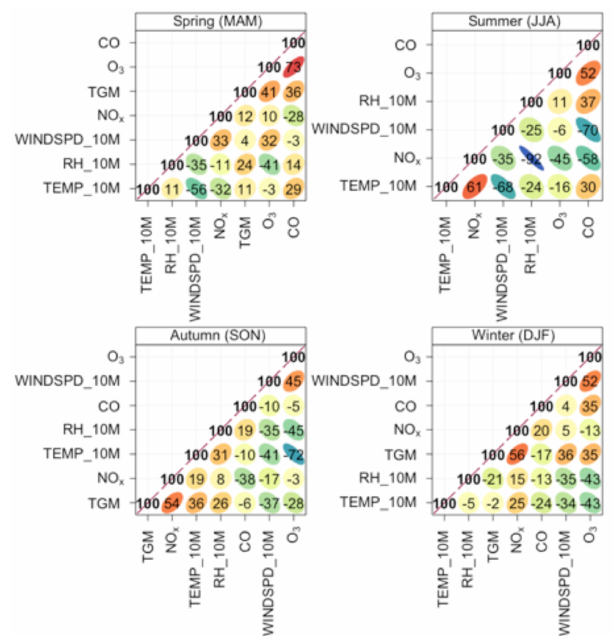
Figure 7. A correlation matrix separated by season to show the cor- relation between pairs of data, using the corPlot function in Openair (Carslaw and Ropkins, 2012). The ellipses are visual representa- tions of a scatter plot. The colour scale highlights the strength of the correlation (red being the strongest and blue the weakest), and the number is the r 2 of the data. The data were daily averaged be- fore correlating to remove any bias from diurnal variability. The or- der the variables appear is due to their similarity with one another, through hierarchical cluster